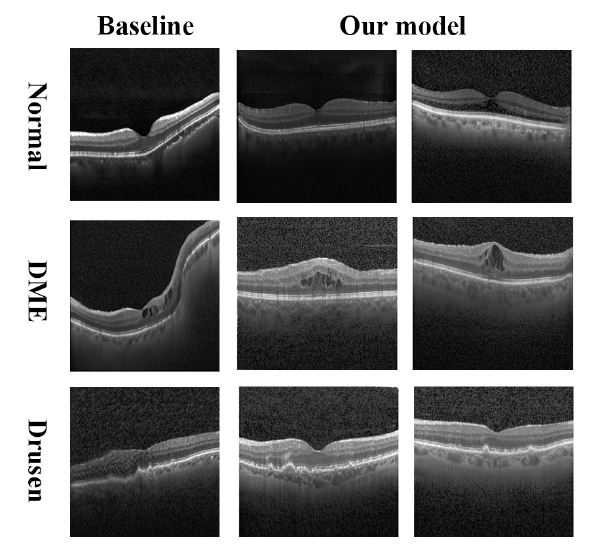
Figure 4. Synthetic images of normal ( first row ), DME ( second row ), and drusen ( third row ) from the baseline ( first column ) and our model ( second and third columns